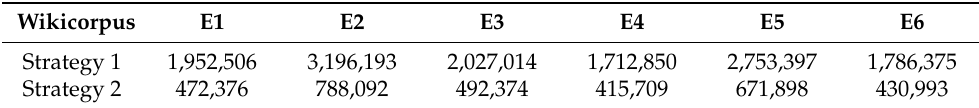
Table 4. Number of sentences for each error type for the Wikicorpus datasets. Error types: genre (E1), number (E2), genre-number (E3), homophone (E4), Hunspell-generated (E5) and subject-verb concordance (E6).